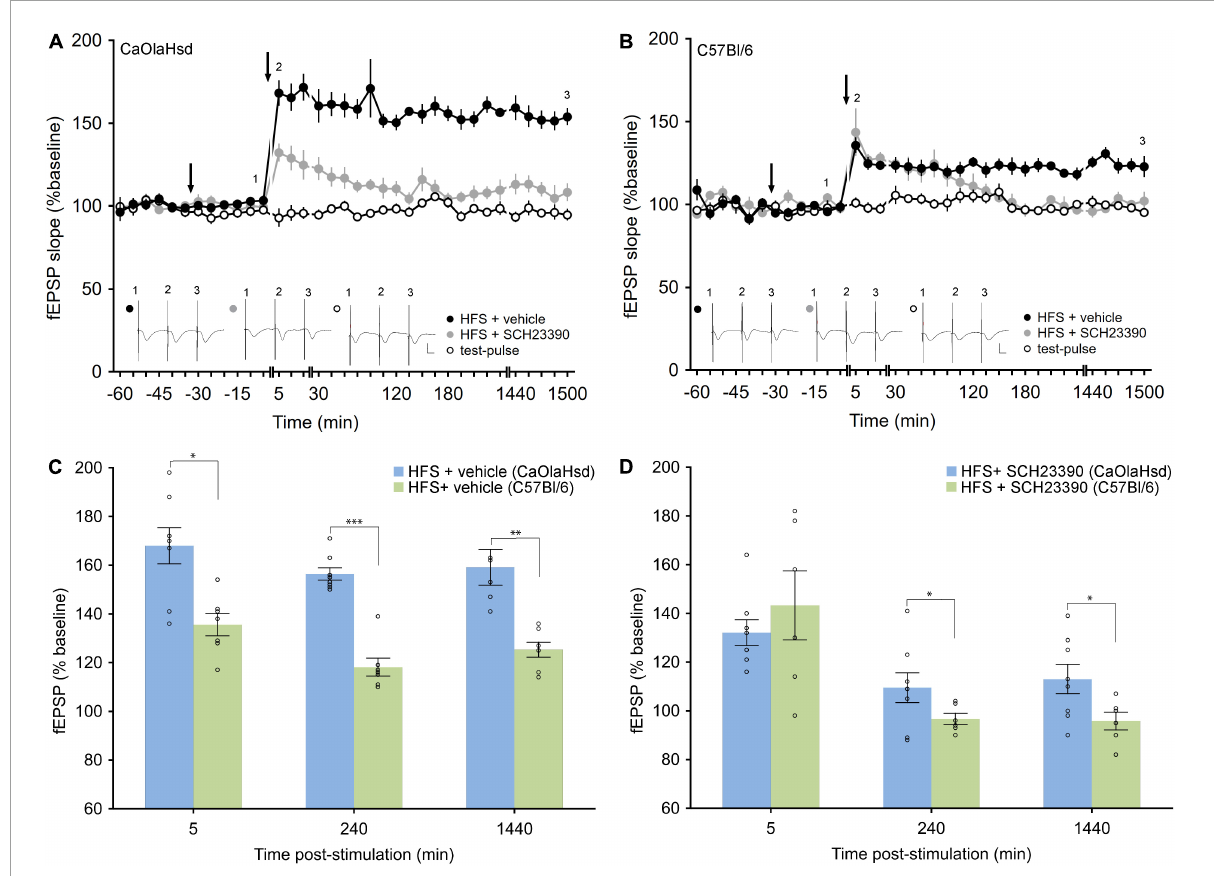
FIGURE3 Effect of the D1/5 receptor antagonism on LTP in CaOlaHsd and C57Bl/6 mice. (A) High frequency stimulation (HFS) of the SC-CA1 pathway (second arrow) results in LTP in CaOlaHsd mice (solid black circles) that was significant compared to test-pulse stimulation ( p < 0.001, open black circles ). Treatment with the D1/D5 receptor antagonist (first arrow) , results in an impairment of the early and late phase of LTP ( p < 0.001, solid gray circles ). Inset shows analog traces recorded at the time points indicated by the numbers in the graph. Line breaks indicate change in time-scale. Vertical scale bar corresponds to 2 mV and horizontal scale bar corresponds to 10 ms. (B) HFS of the SC-CA1 pathway (second arrow) results in a smaller and less persistent LTP in C57Bl/6 mice compared to CaOlaHsd mice (solid black circles) that was significantly different compared to test-pulse stimulation (open black circles). Injection of the D1/D5 receptor antagonist (first arrow) , resulted in an impairment of the late phase of LTP (solid gray circles) . Inset shows analog traces recorded at the time points indicated by the numbers in the graph. Line breaks indicate change in time-scale. Vertical scale bar corresponds to 2 mV and horizontal scale bar corresponds to 10 ms. (C,D) Bar charts display the difference in evoked responses between CaOlaHsd (blue) and C57Bl/6 mice (green) at different time-points after stimulation in LTP control experiments (C) and after injection of SCH23390 (D) . Open circles represent single data-points. Significant values are denoted by asterisks: ∗ p < 0.05, ∗∗ p < 0.01 and ∗∗∗ p <